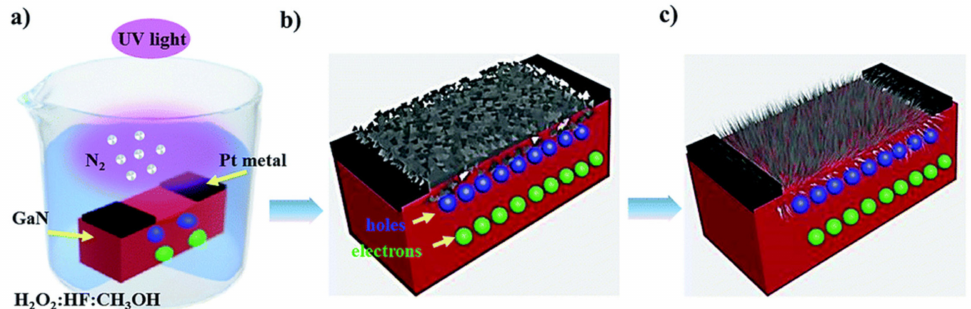
Figure 4. Schematic etching mechanism of GaN nanowires. ( a ) The reaction of the surface with H 2 O 2 : HF: CH 3 OH solution under UV light and generation of electron-hole pairs, ( b ) synthesis of porous GaN or InGaN for short etching times, and ( c ) synthesis of nanowires for longer etching times. Reproduced from [46], with permission from Copyright Royal Society of Chemistry,